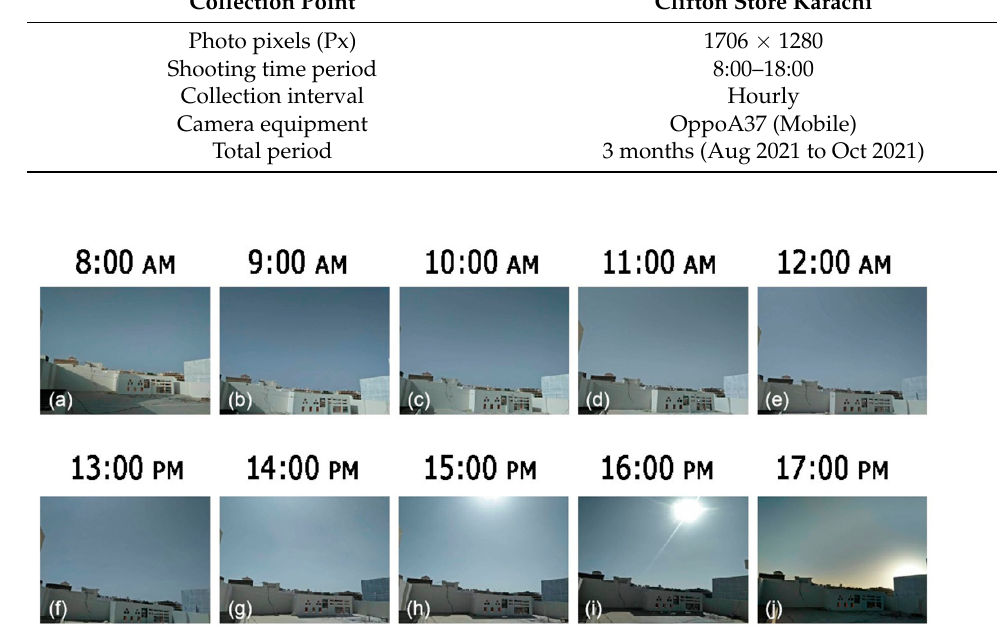
Figure 2. Scene image examples from the KHI image library.